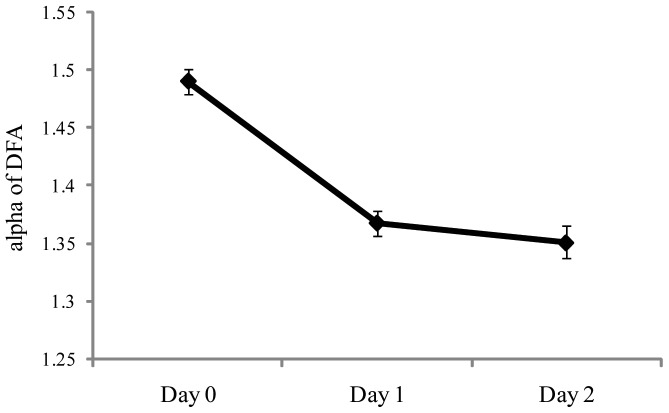
Experiment 2: Meanα of DFA as a function of days.The figure illustrates the statistically significant effect of days. The error bars represent standard error of the mean.